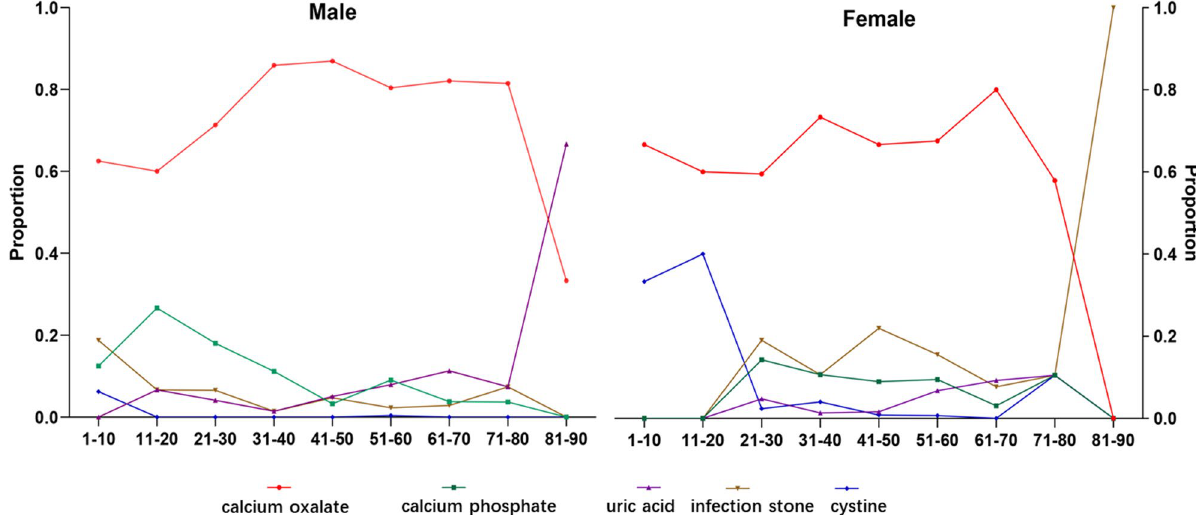
Figure 1. Proportions of stone compositions in different genders and age groups.